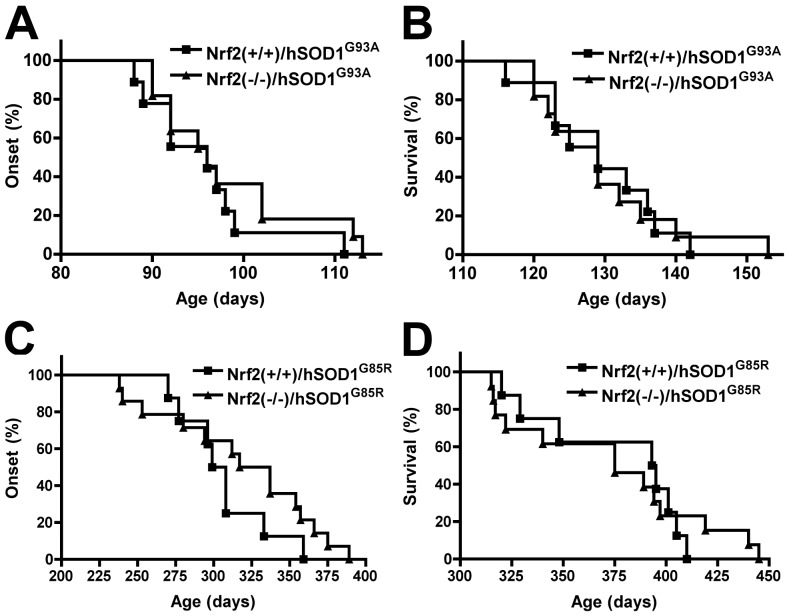
Absence of Nrf2 does not exacerbate neurodegeneration in mutant hSOD1 mice.A) Median onset in Nrf2(+/+)/hSOD1G93A (96 days, n = 9) and Nrf2(-/-)/hSOD1G93A mice (96 days, n = 11). B) Median survival in Nrf2(+/+)/hSOD1G93A (129 days, n = 9) and Nrf2(-/-)/hSOD1G93A mice (129 days, n = 11). Onset and survival curves are not significantly different. C) Median onset in Nrf2(+/+)/hSOD1G85R (303.5 days, n = 8) and Nrf2(-/-)/hSOD1G85R mice (327 days, n = 14). B) Median survival in Nrf2(+/+)/hSOD1G85R (394 days, n = 8) and Nrf2(-/-)/hSOD1G85R (375 days, n = 13). Onset and survival curves are not significantly different.